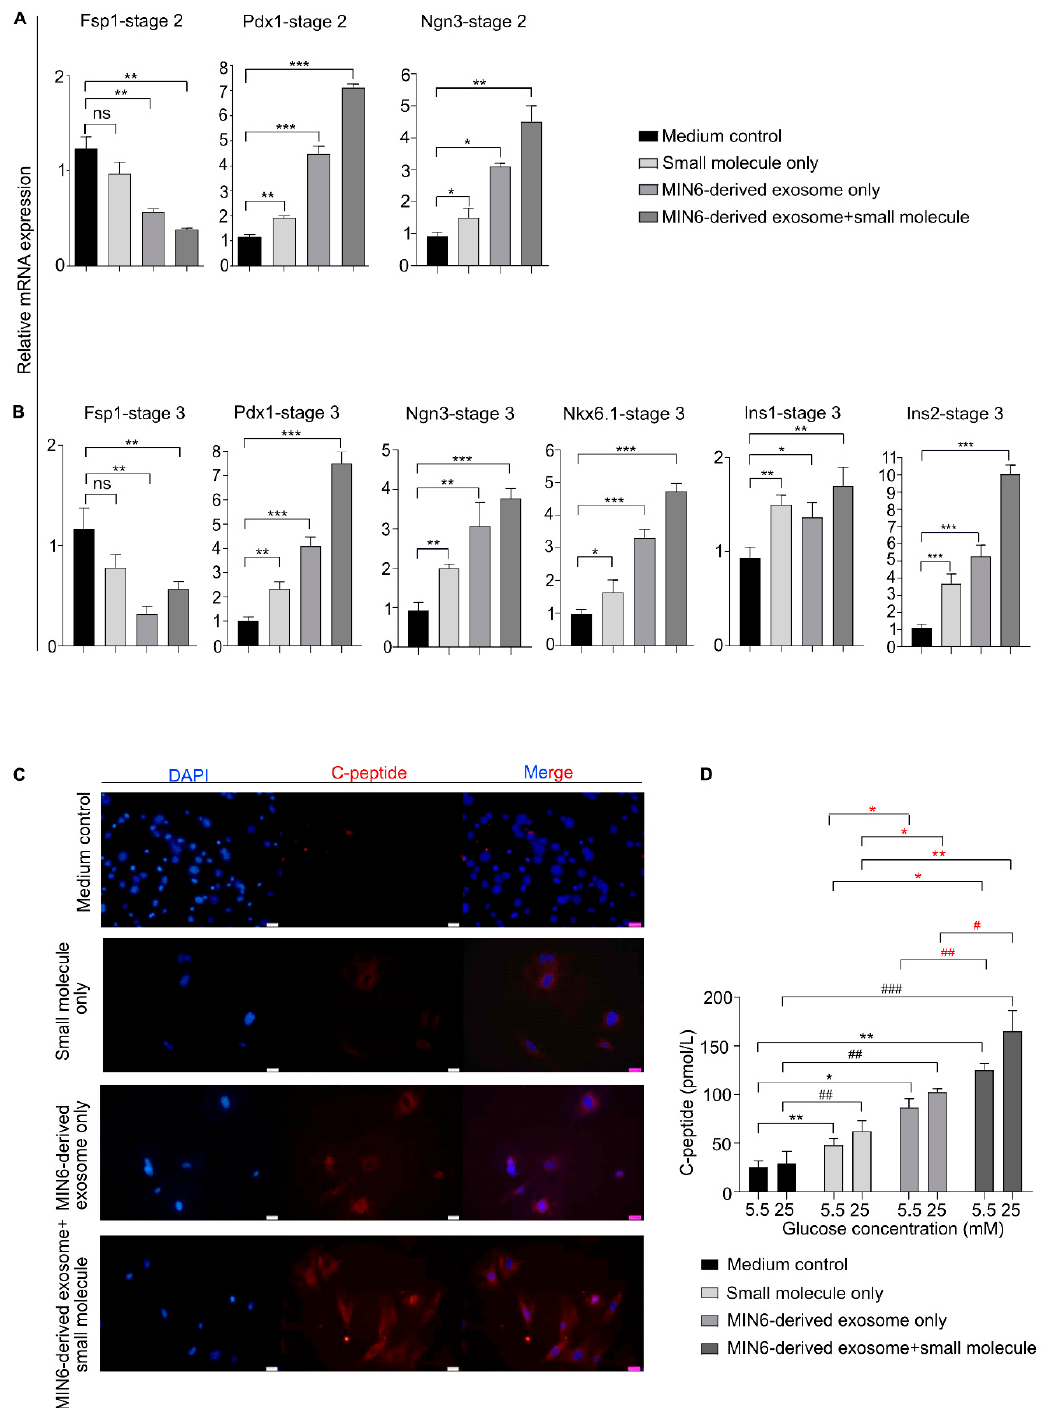
Figure 4. MIN6-derived exosome and small molecule combination enhanced the differentiation of MEFs into β -like cells. ( A ) Relative transcript levels of Fsp1, Pdx1, and Ngn3 in differentiated cells at the end of stage 2. ( B ) qRT-PCR analysis of Fsp1 and different pancreatic genes in differentiated cells after the completion of stage 3. The cells had been exposed to small molecule only, MIN6-derived exosome only, or MIN6-derived exosome + small molecule in stage 1 and then differentiated further. ( C ) Immunostaining for the detection of C-peptide protein in cells grown under different conditions after stage 3. Scale bar = 20 µm. ( D ) C-peptide release assay to determine the functionality of the